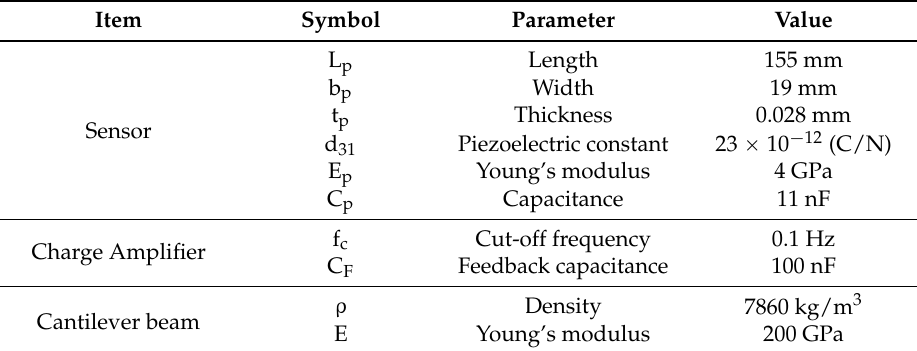
Table 1. Input parameters for